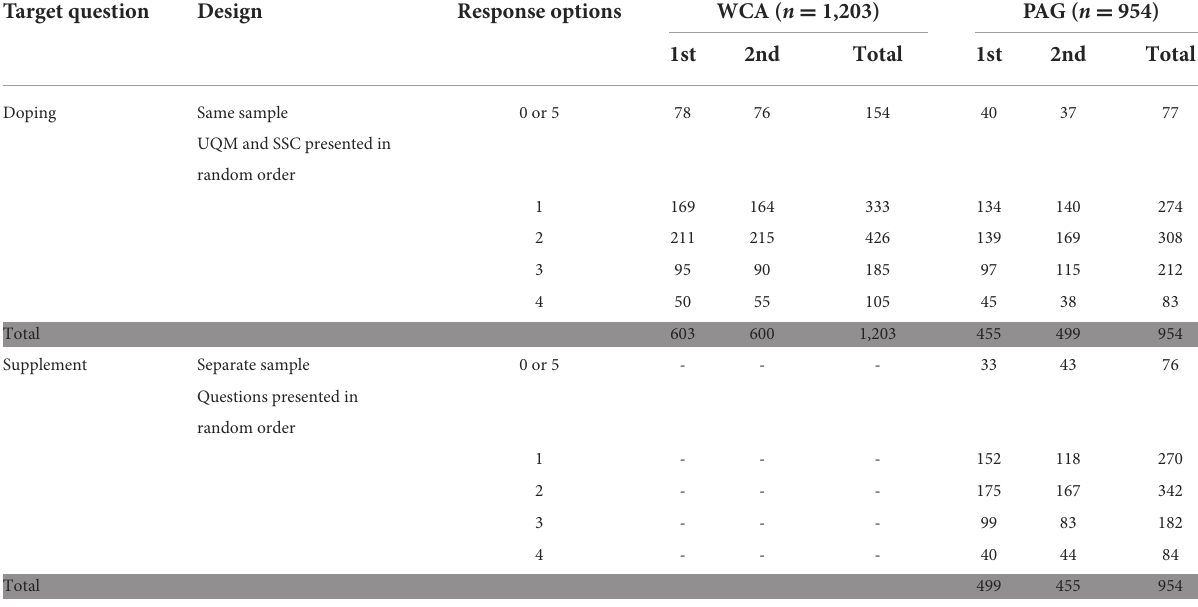
TABLE 3 Frequency counts of the SSC response options obtained at the two sport events (WCA and PAG) in 2011, alongside the UQM method. Target question